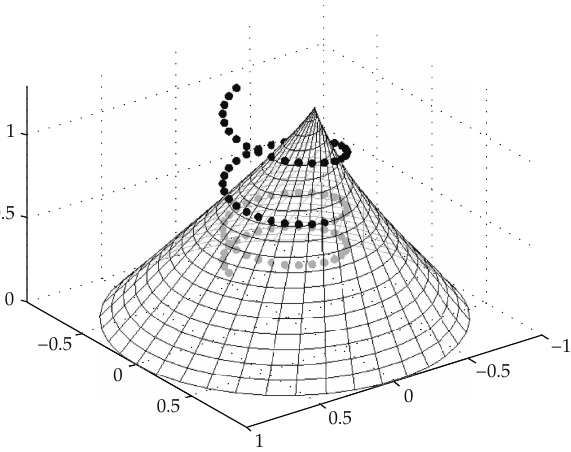
Figure 7: The stability cone and points M (cid:5) s (cid:8) for Example 6.2. Grey points M (cid:5) s (cid:8) (cid:5) 1 inside the cone therefore (cid:5) 6.4 (cid:8) is stable. Dark points M (cid:5) s (cid:8) (cid:5) s